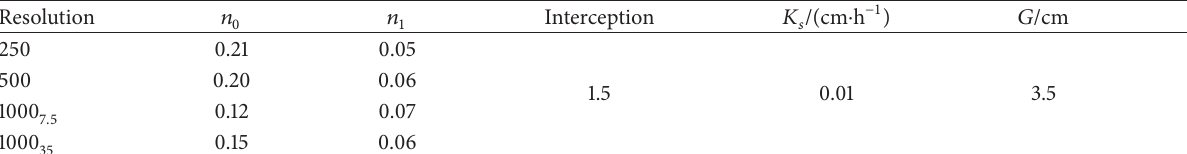
Table 4: Parameters and initial values of Luanchuan catchment.